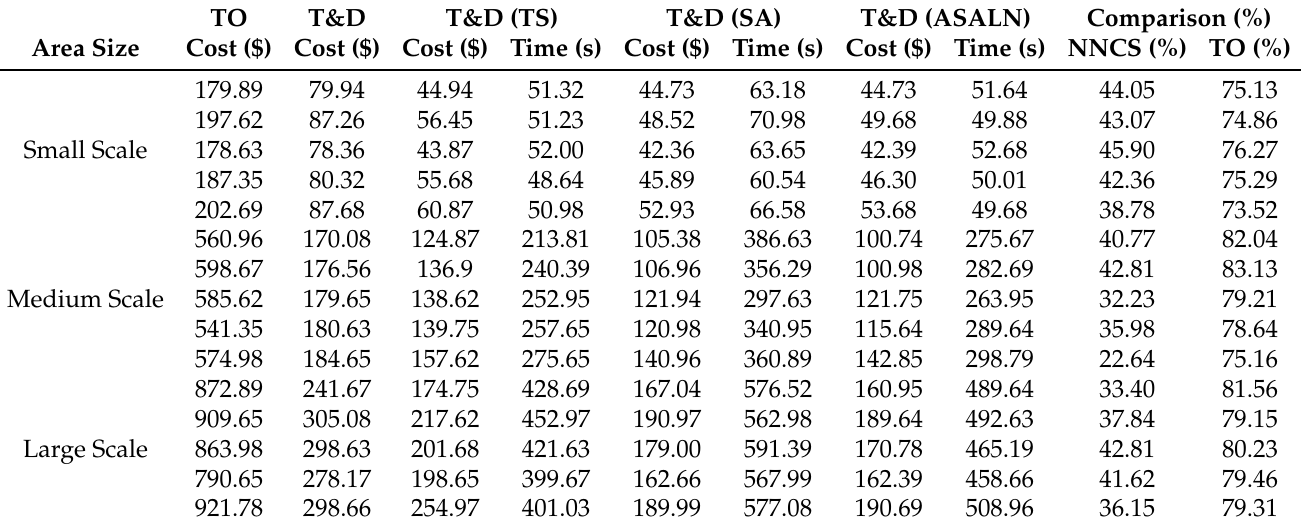
Table 4. Experimental results on synthetic cases on three scales